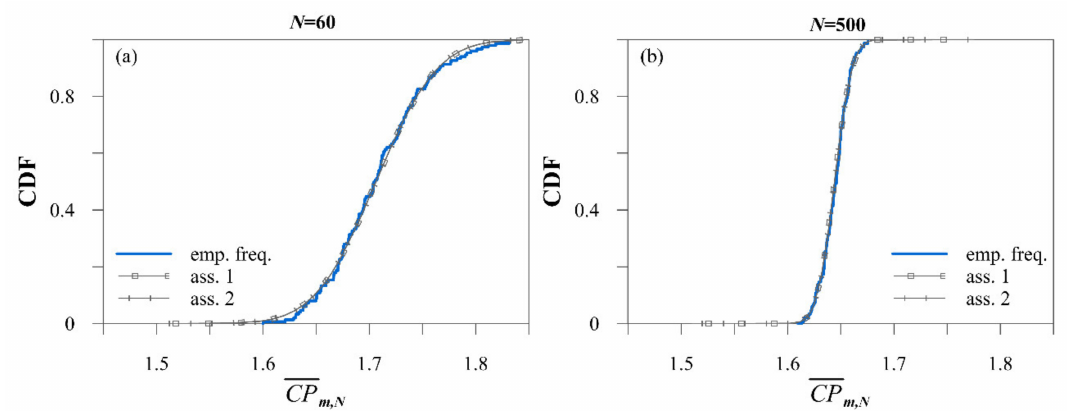
Figure 9. Empirical vs. theoretical probability distributions of sample means for Cluster 2 under two di ff erent assumptions for the underlying normal model: ( a ) N = 60 and ( b ) N =